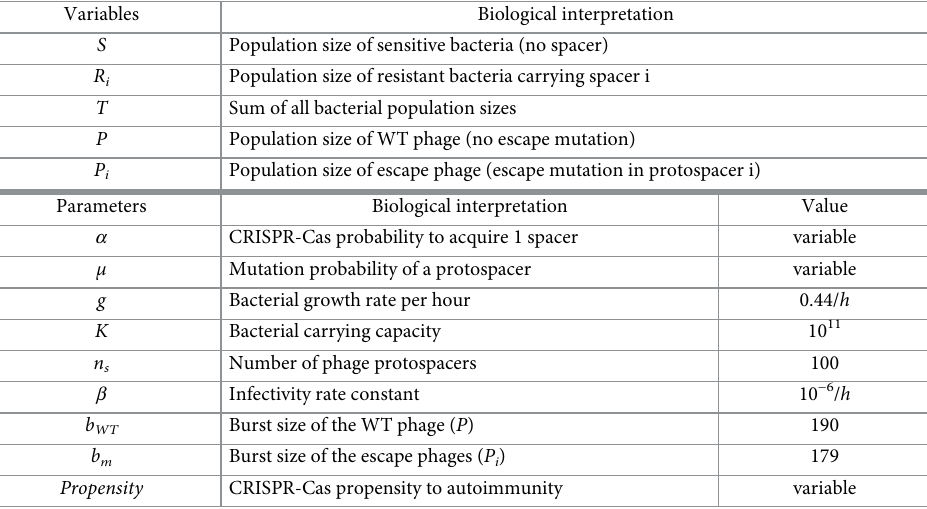
Table 1. Summary of the variables and parameters used in the